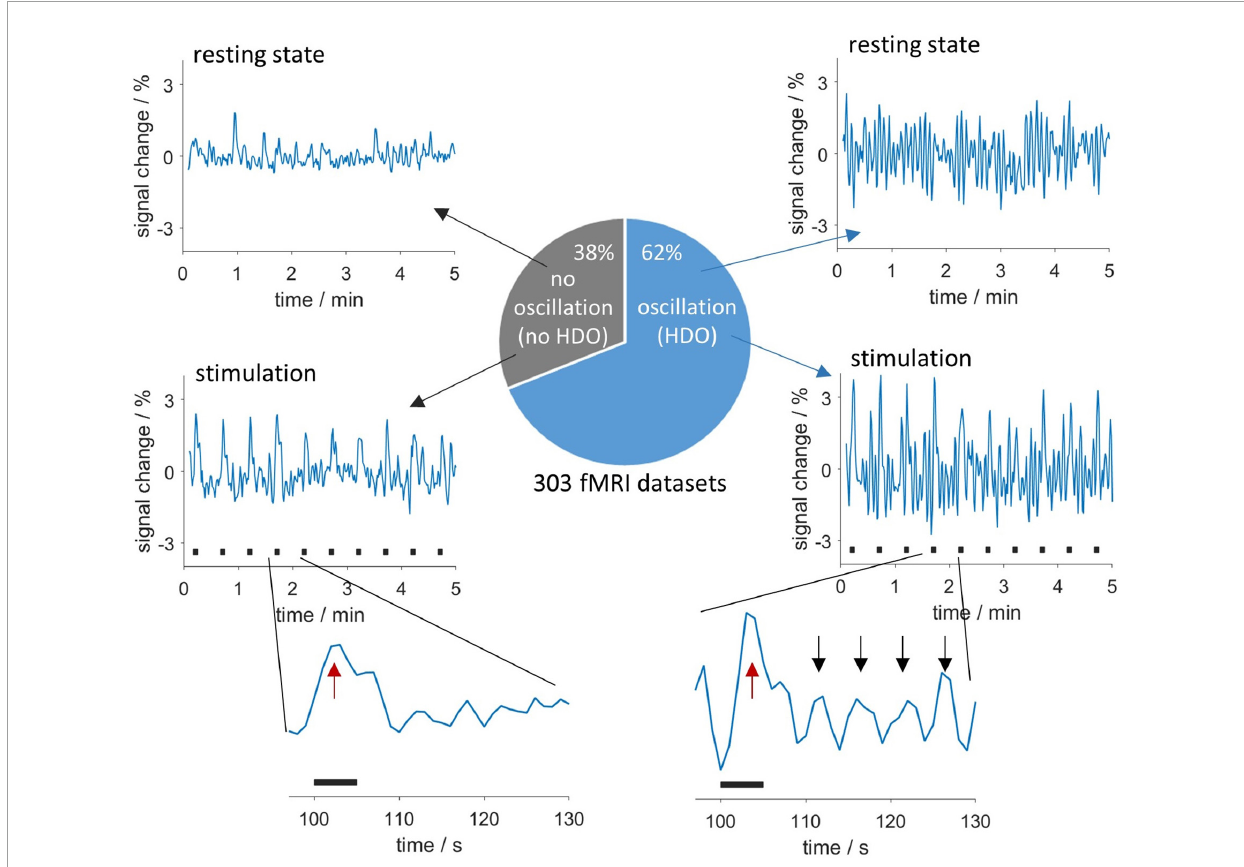
FIGURE2 Appearance and occurrence of HDO. Periodic oscillations in fMRI time courses were investigated in 303 measurements. In total, 62% of the measurements showed HDO which had a period of approximately 5 s. Exemplary time courses without and with HDO for resting state data are shown in the (upper row) and data recorded during sensory stimulation in the (middle row) . Stimulation periods are indicated by black bars. Enlarged segments of one paradigm repetition (bottom row) showed that HDO (maxima indicated by black arrows) were triggered by the BOLD response (red